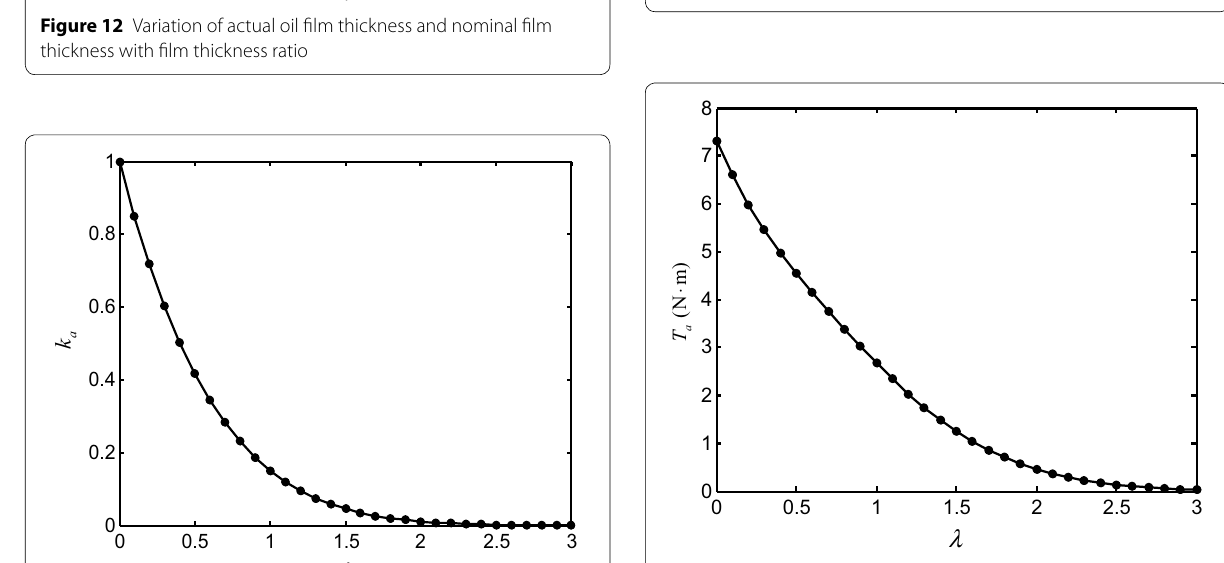
Figure 14 Variation of oil film shear torque with film thickness ratio